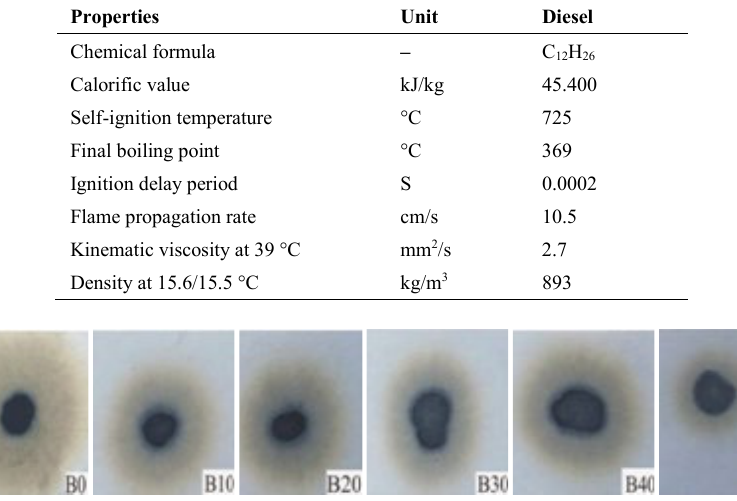
Fig. 3. Result of homogeneity